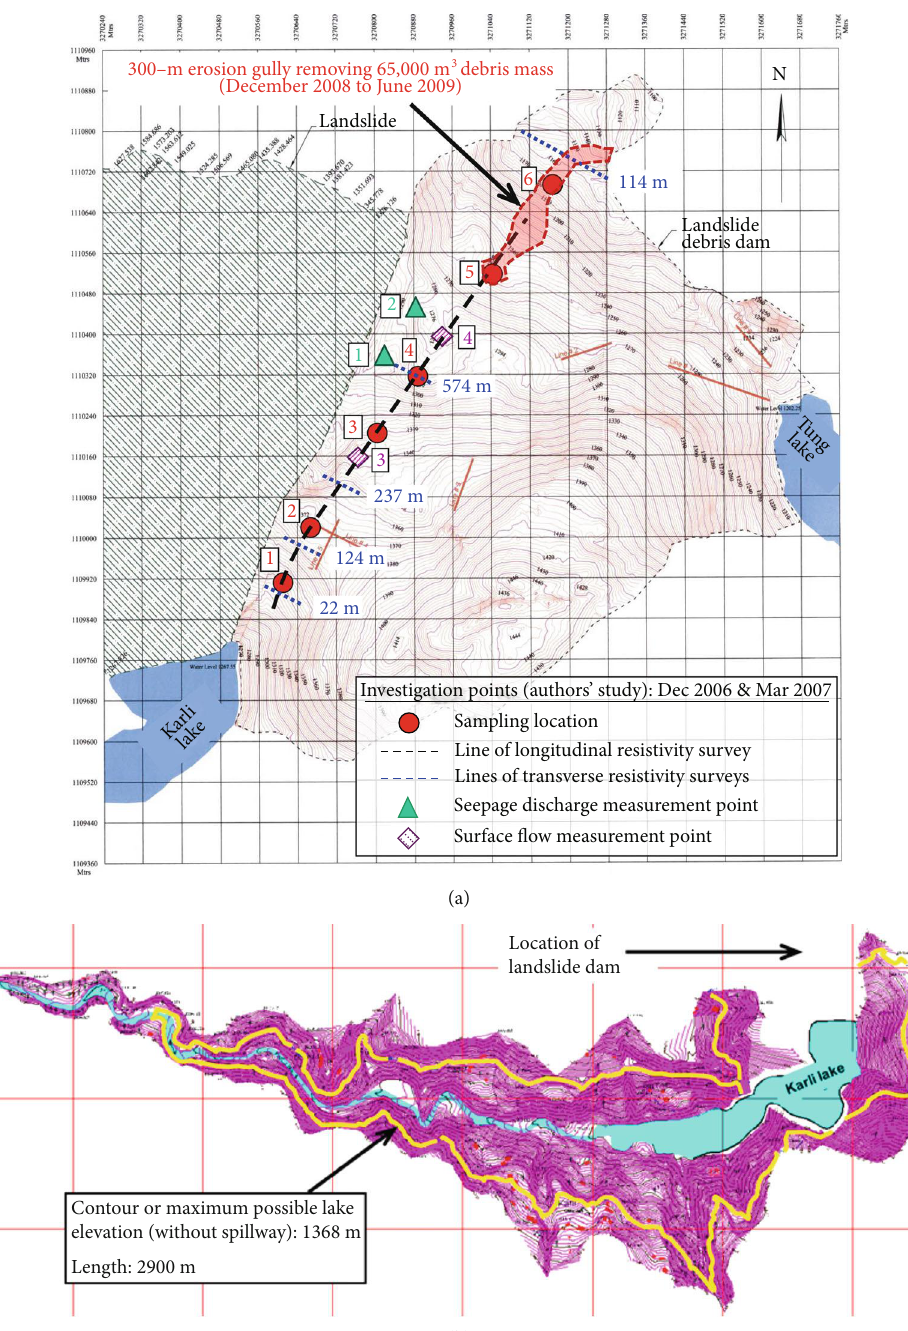
Figure 5: (a) 2 m contour interval topographical map of Hattian Bala landslide dam showing the fi eld investigation points of the authors ’ study (measurements made in December 2006 and March 2007) and the rim of erosion gully (developed between December 2008 and June 2009); (b) 2m contour interval topographical map of Karli lake area (adapted from